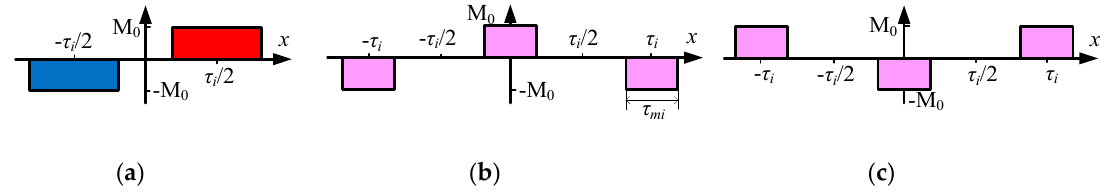
Figure 5. Distributions of axial and circumferential magnetization intensities: ( a ) Axial magnetized magnets of the upper and lower Halbach array. ( b , c ) Circumferential magnetized magnets of the upper and lower Halbach array.